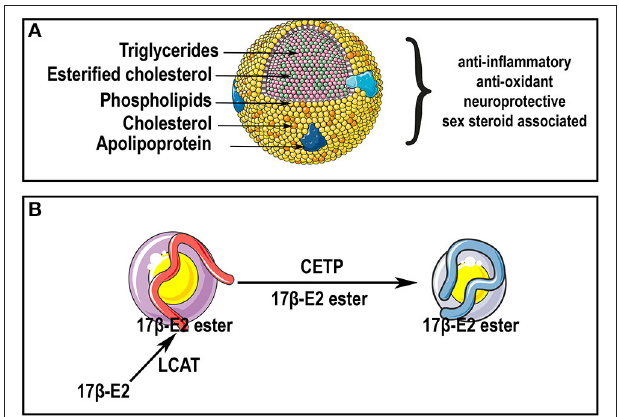
FIGURE 5 | HDL particles and sex steroids. (A) Lipoprotein particles display a central core containing cholesterol, cholesterol esters and triglycerides, that is enveloped by free cholesterol, phospholipids, and apolipoproteins. HDL particles display pleiotropic effects partly supported by their anti-inflammatory, anti-oxidant and neuroprotective properties. HDLs have been shown to display metabolic interaction with sex steroids (i.e., androstenediol, estradiol, DHEA, dihydrotestosterone, pregnenolone, and progesterone). (B) As suggested by Tikkanen et al. (2002), 17 β -E2 could be esterified with fatty acids by lecithin:cholesterol acyltransferase (LCAT) in HDL. Esterified 17 β -E2 could be subsequently transferred from HDLs to LDLs by cholesteryl ester transfer protein (CETP). Thus, HDL particles could be a source of cholesterol and steroids in the brain notably after CNS insults, and could be used as a carrier for improving steroids delivery in therapeutically